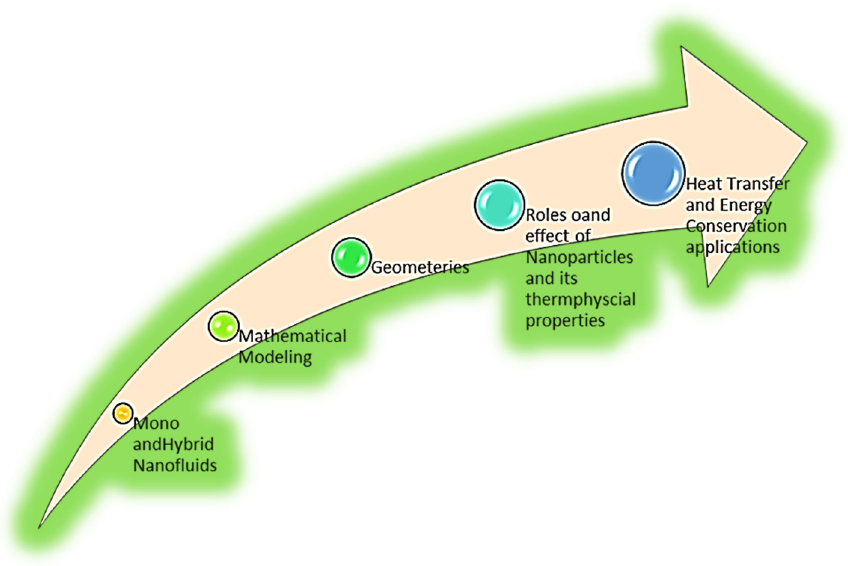
Figure 5. The flow of the